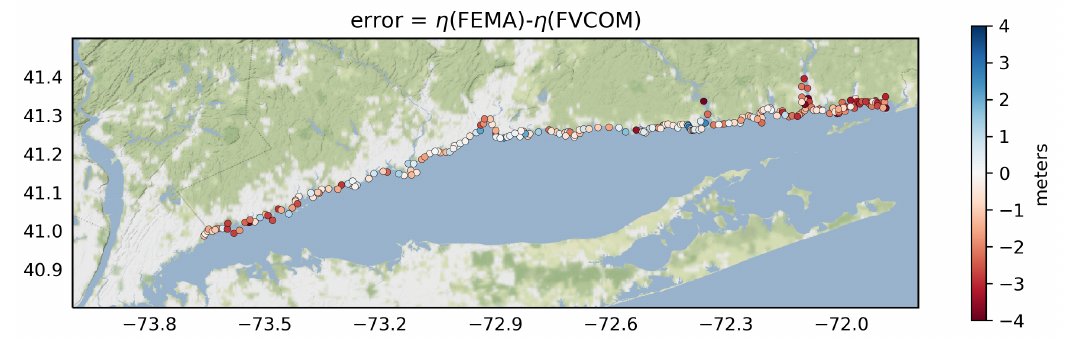
Figure 9. The average error of 100-year water level between model and FEMA estimates. Red indicates that model values are higher than